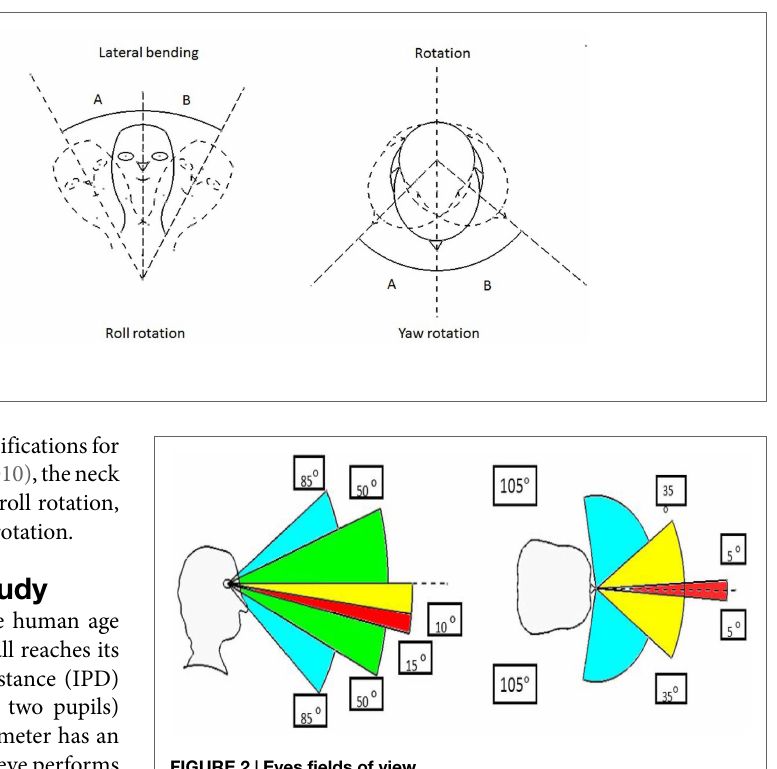
FIGURE 2 | Eyes fields of view